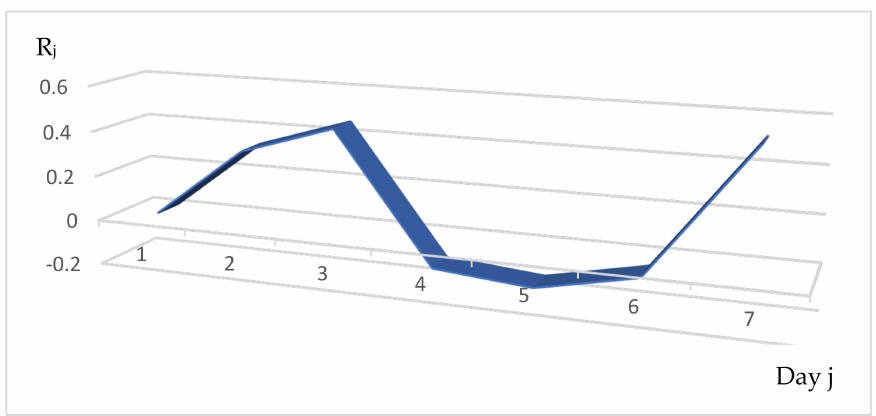
Figure A7. Values of the daily reproduction numbers R j along the period of contagiousness of length 7 days.